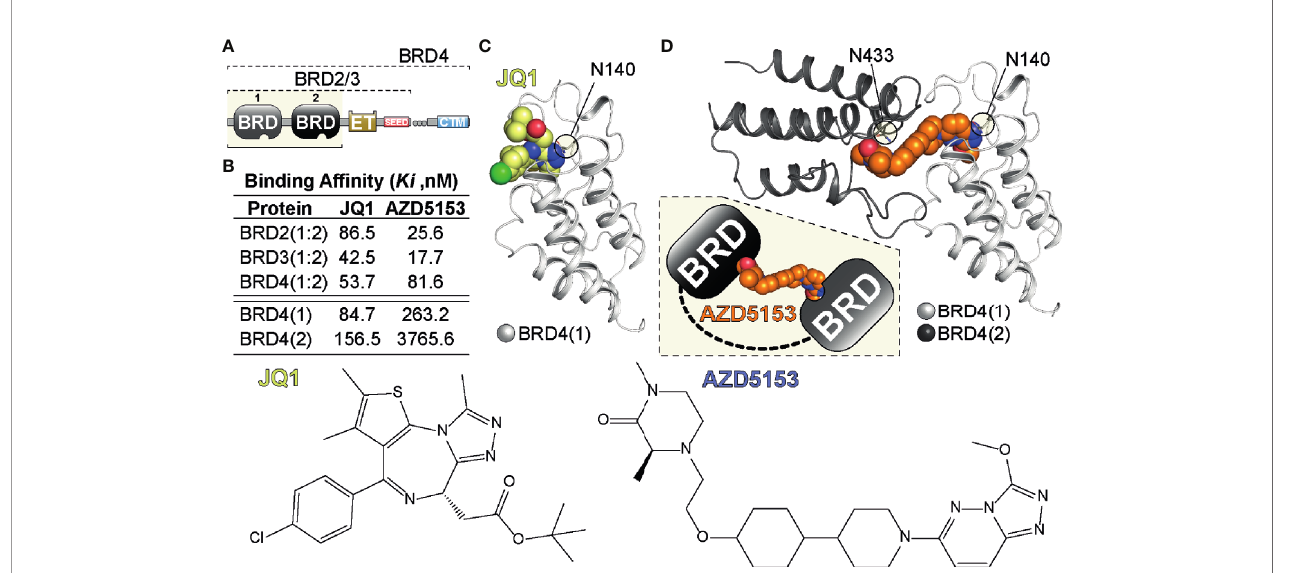
FIGURE 1 | Tandem BET BRD targeting. (A) Domain organization of BET (BRD2,3,4) proteins highlighting the N-terminal tandem bromodomain (BRD) modules, the Extra-Terminal (ET) and C-terminal motif (CTM) as well as SEED region. (B) Binding af fi nities of single (JQ1) and tandem (AZD5153) BET inhibitors previously determined in a Fluorescent polarization (FP) assay (11). (C) Single BRD4 site engagement by JQ1. The inhibitor is shown as a CPK model engaging BRD4(1) via Asn140 (N140), the amino acid residue in the acetyl-Lys binding pocket of BRD4(1) (12). (D) Model of tandem BRD4(1:2) engagement by AZD5153. The inhibitor (shown as a CPK model) engages BRD4(1) via N140 and BRD4(2) via N433 linking the tandem BRD modules as indicated in the inset. The model was generated from PDBs 5KHM and 2OUO